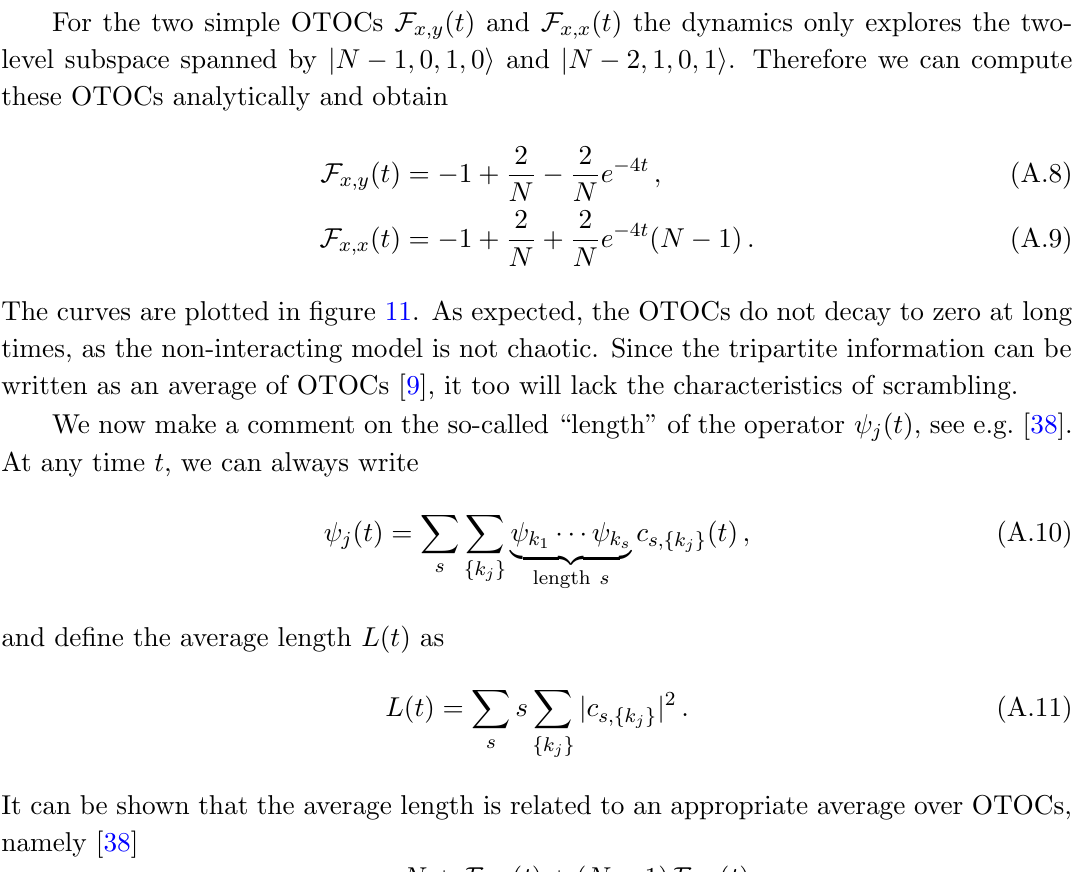
( t ) (solid lines) and ( t ) (dashed lines) for single site Majorana F x;x F x;y